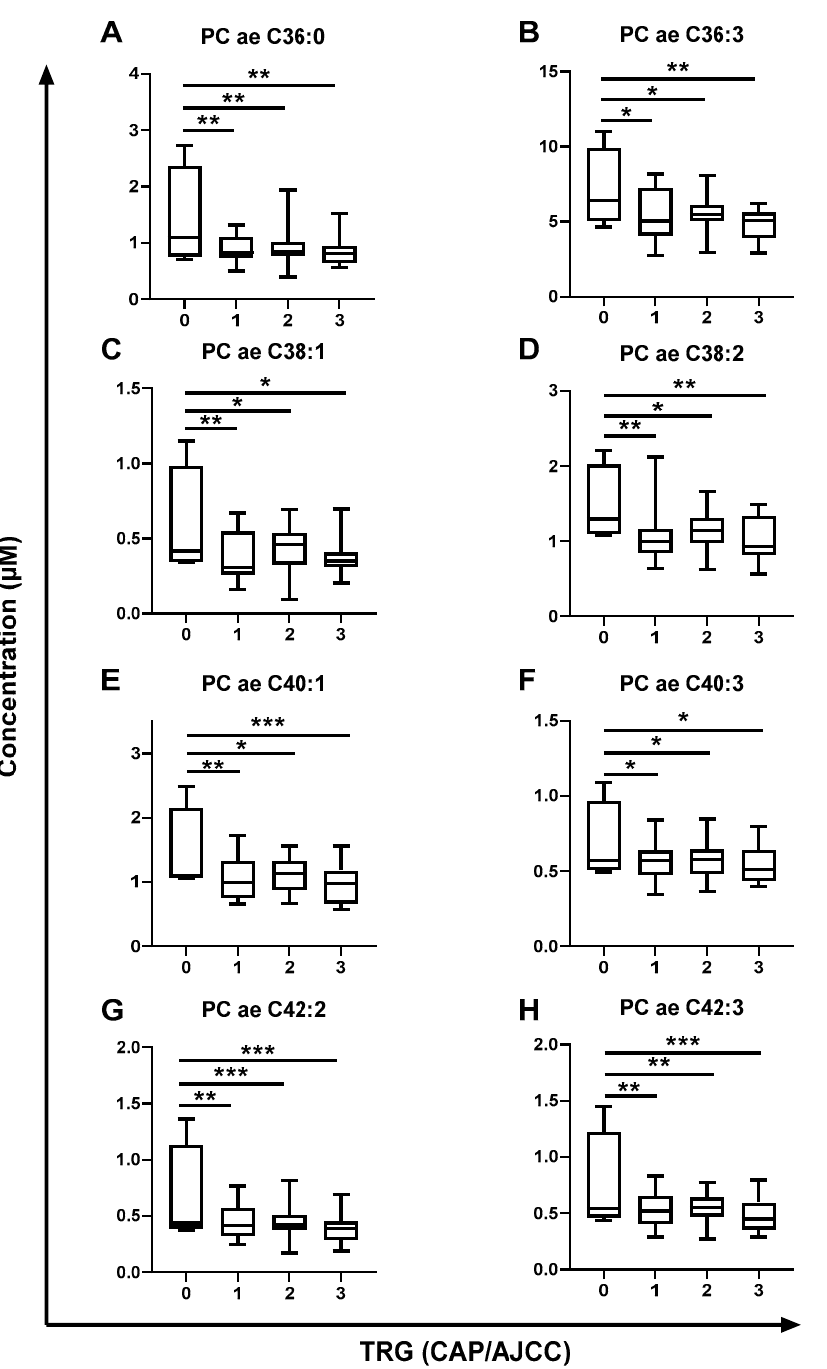
Figure 7. Pre-treatment serum metabolite levels were significantly altered across TRG in rectal cancer patients. Metabolite levels in pre-treatment sera from rectal adenocarcinoma patients ( n = 52) were assessed by liquid chromatography mass spectrometry (LC-MS) and correlated with subsequent pathological response to neoCRT. ( A ) PC ae C36:0, ( B ) PC ae C36:3, ( C ) PC ae C38:1, ( D ) PC ae C38:2, ( E ) PC ae C40:1, ( F ) PC ae C40:3, ( G ) PC ae C42:2 and ( H ) PC ae C42:2 levels were significantly decreased with increasing TRG and worse therapeutic response. TRG 0, n = 4; TRG 1, n = 14; TRG 2, n = 22; TRG 3, n = 12. Data are presented as medians ± minima/maxima. Statistical analysis was performed by post hoc unpaired GLM analysis. * p < 0.05, ** p < 0.01, *** p < 0.001. Lyso PC a C28:0 was significantly lower in pre-treatment sera from patients with a sub- sequent poor response (TRG 2 and TRG 3) when compared to those with a complete patho- logical response (TRG 0) (Figure 6A). Five diacyl (aa) PC metabolites (PC aa C36:2, PC aa